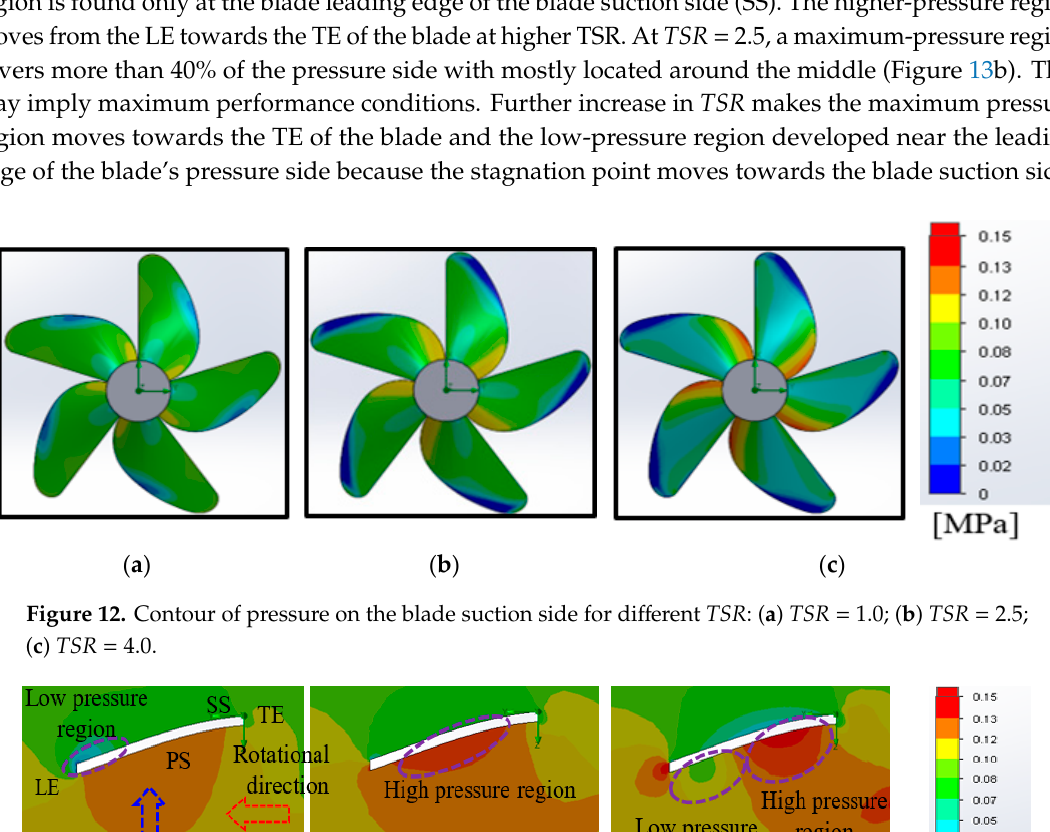
Figure 13. Pressure distribution mid span of the flow passage for various TSR : ( a ) TSR = 1.0; ( b ) TSR = 2.5; ( c ) TSR = 4.0.